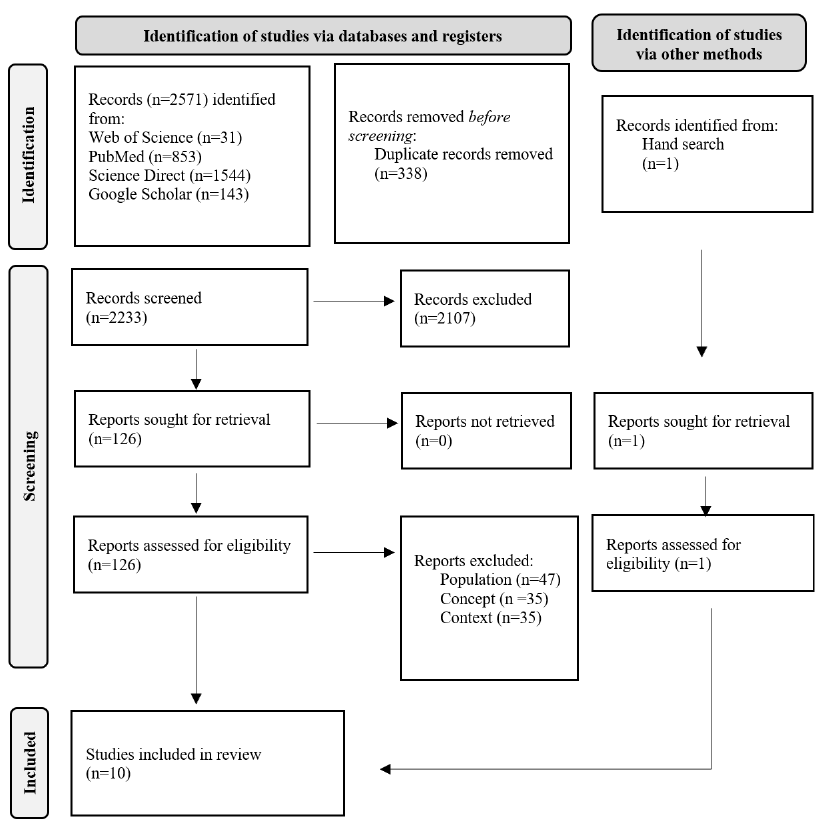
Figure 1. Flow diagram for the scoping review process adapted from the PRISMA-ScR statement [20] . In total, 10 studies enrolled a total of 261